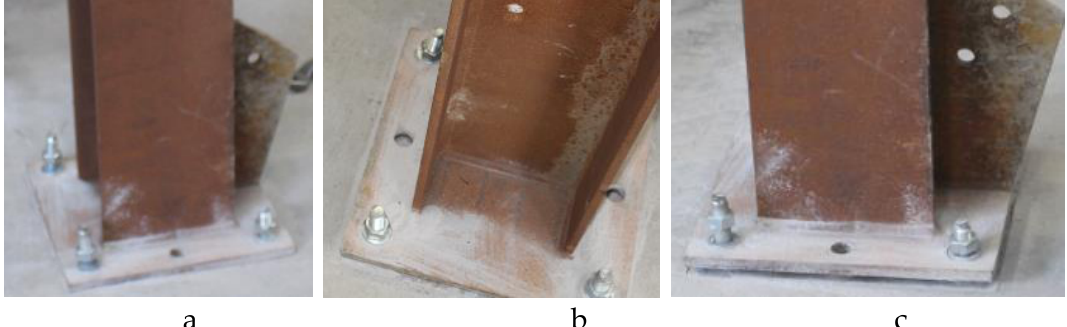
Figure 19. Introduction of column level deviation: ( a ) base column position; ( b ) 10 mm shim plate; ( c ) column raised 10 mm.